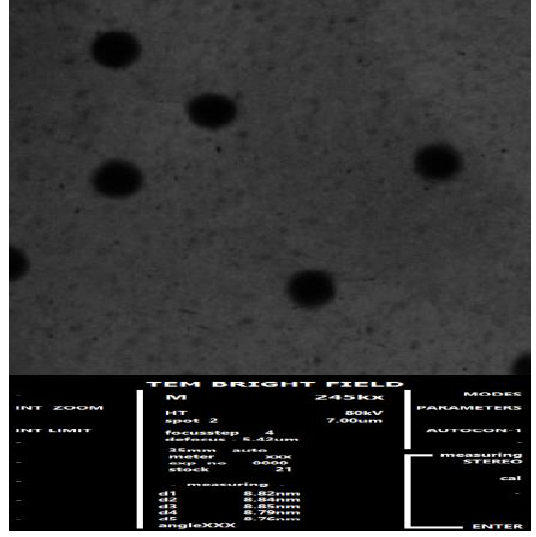
Figure 19. TEM 2D images of the optimized gold nanoparticles G21